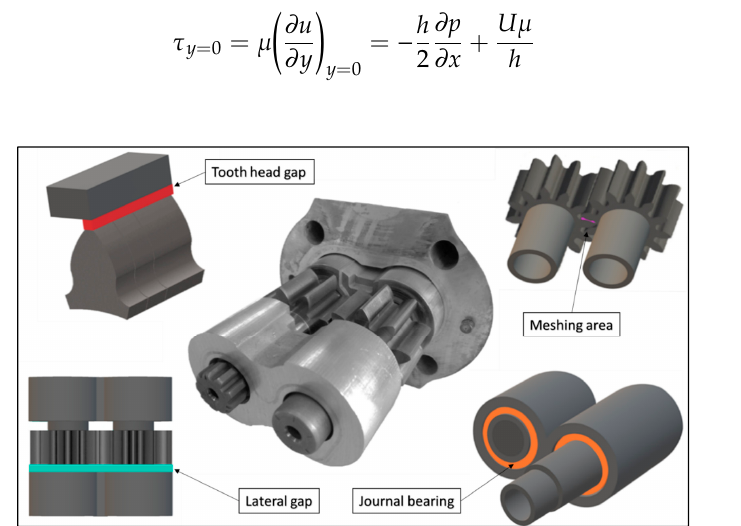
Figure 1. External gear pump components and identification of the mechanical-viscous sources of loss.